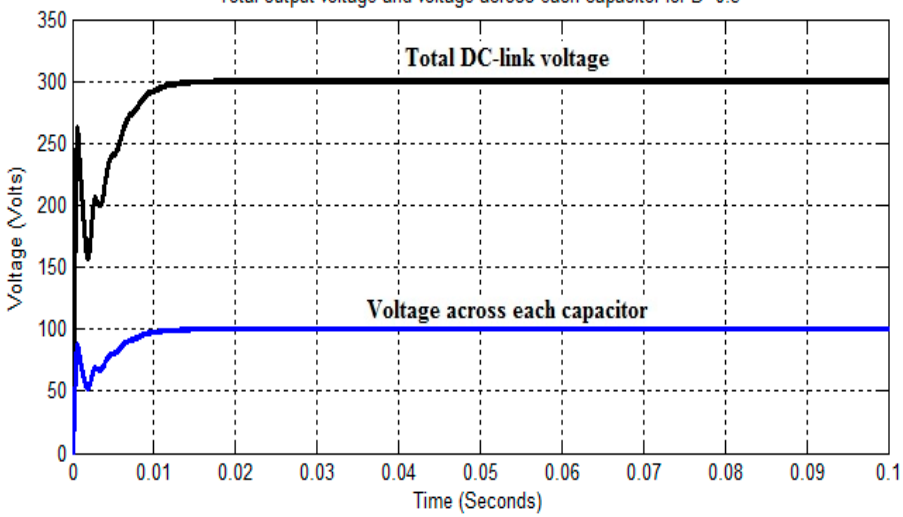
Figure 14. Output of TLBC in closed-loop for D = 0.5.